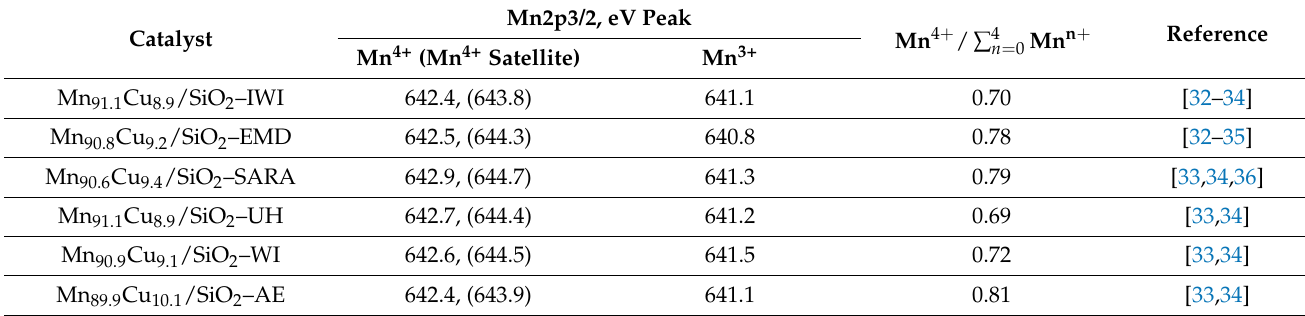
Table 3. Binding energies and the corresponding oxidation states of Mn2p XPS spectra for the prepared Mn-based catalysts.